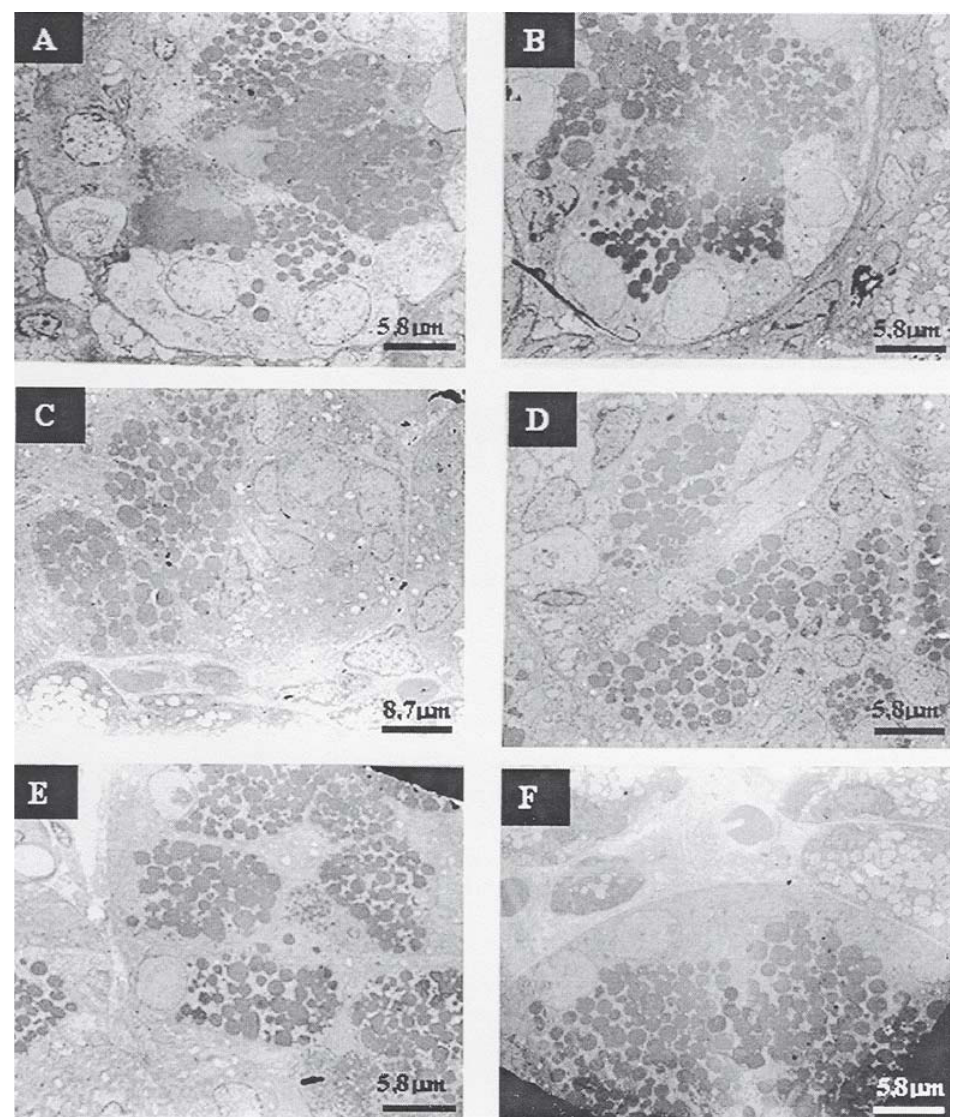
FIGURE 3- (A) Serous cells from the irradiated group 12 h (A,B) and 24 h (C,D) after irradiation. (B) Serous cells from the sodium selenite group at 12 h. (C) Serous cells from the sodium selenite/irradiated group at 12 h. (D) Serous cells from the irradiated group at 24 h. (E) Serous cells from the sodium selenite group at 24 h. (F) Serous cells from the sodium selenite/ irradiated group at 24